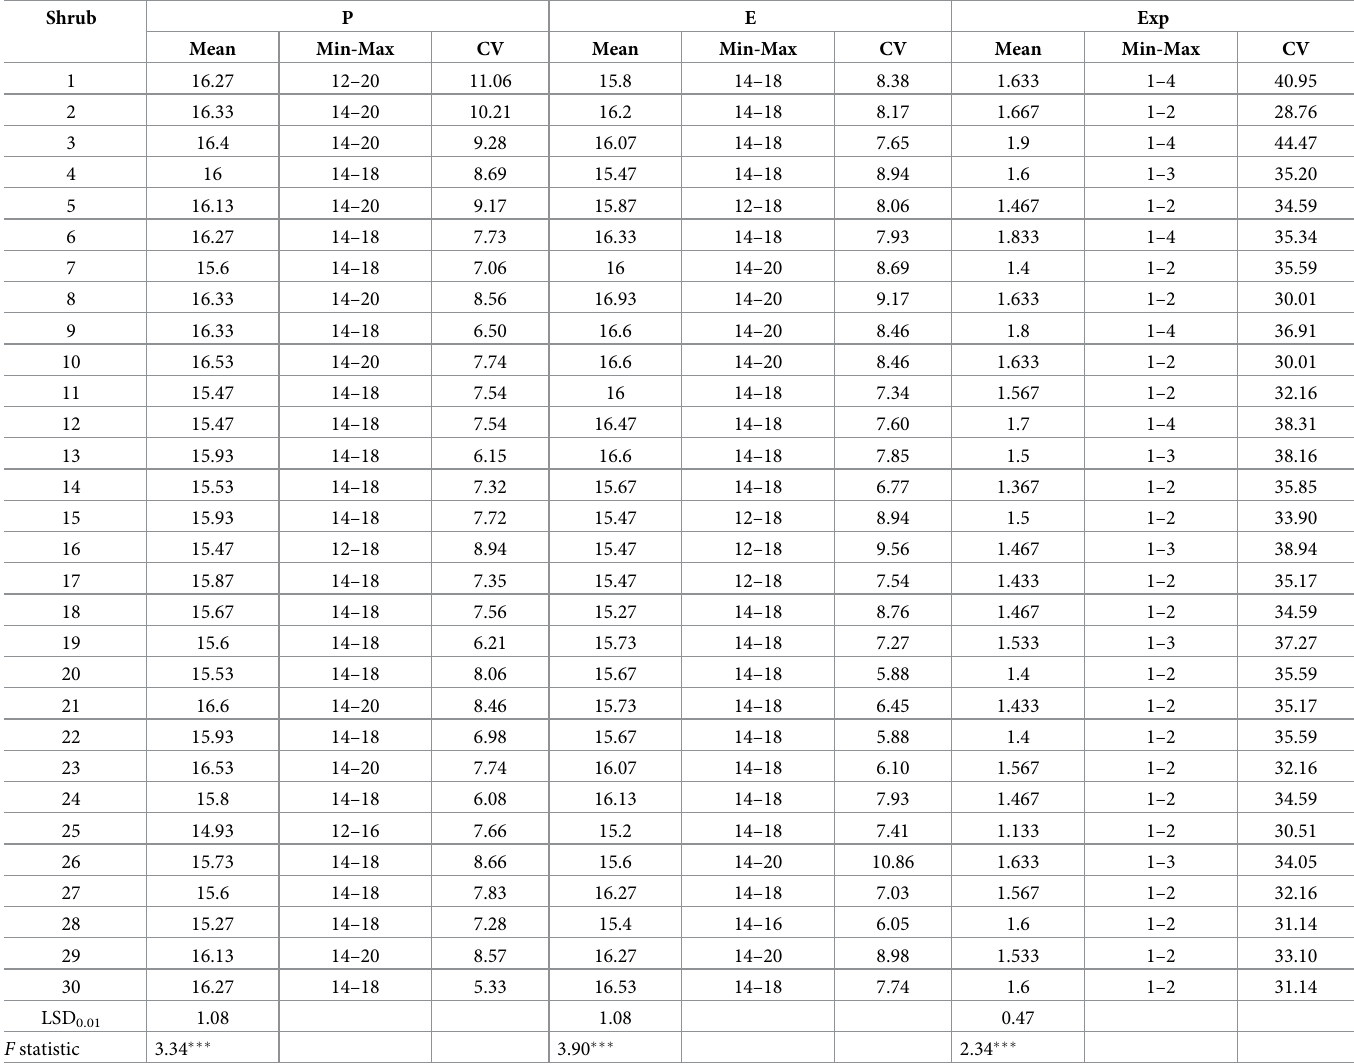
Table 2. Minimal, maximal and mean values as well as coefficients of variation (CV) for P, E and Exp of